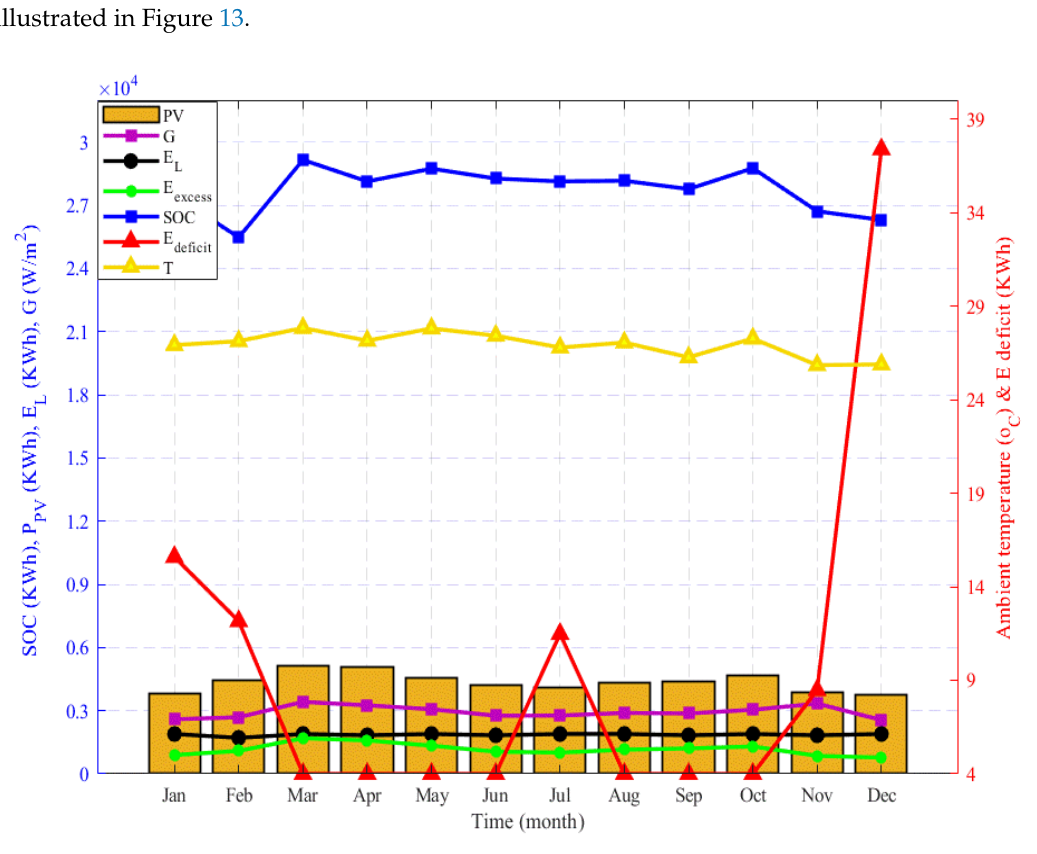
Figure 13. Monthly state of charge (SOC), PV modules (P_PV), load demand (E_L), solar irradiation (G), E_excess, E_deficit, and ambient temperature (T) through one year.